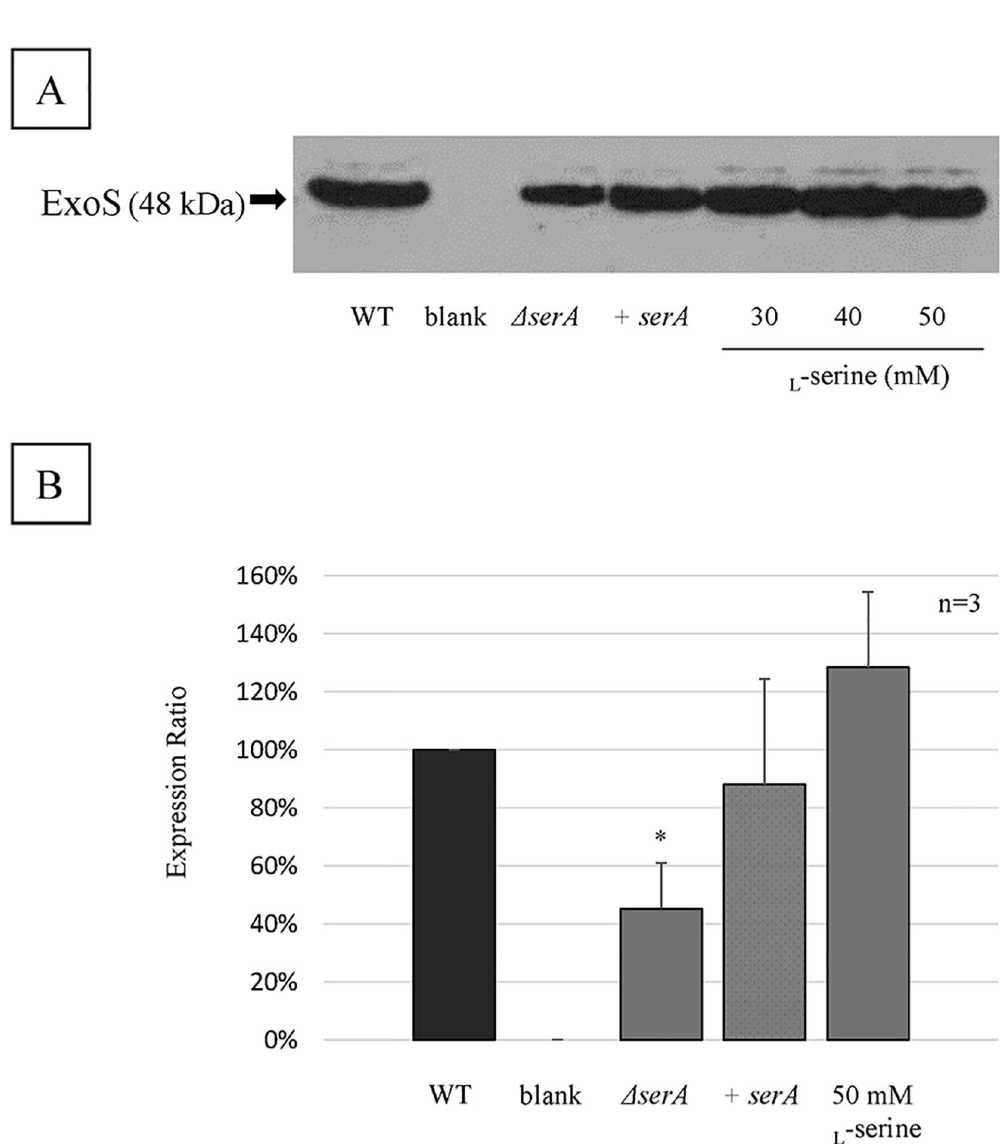
Fig 2. ExoS secretion assay. (A) Western blot analysisto detect secretionof ExoS into the culture supernatant using type III secretionsystem-inducingconditions in the wild-typestrain (WT), PAO1Tn:: serA mutant ( Δ serA ), PAO1Tn:: serA (pUCP19- serA ) complementary strain (+ serA ), and WT in the presence of L -serine (30, 40, and 50 mM). A representative western blot image is shown. The arrow indicatesthe presenceof ExoS with a deduced molecularweight of 48 kDa. (B) Expression ratio of ExoS based on western blot analysesof WT, Δ serA ,+ serA , and WT in the presence of 50 mM L -serine. Western blotting was repeatedthree times, and bands were quantifiedby ImageJ. Data is shown as the ratio of ExoS expressionto that of the wild-typestrain and is expressedas the mean ± SD. A significantdifference was observedfor ExoS expressionbetweenWT and Δ serA ( * : P < 0.05).